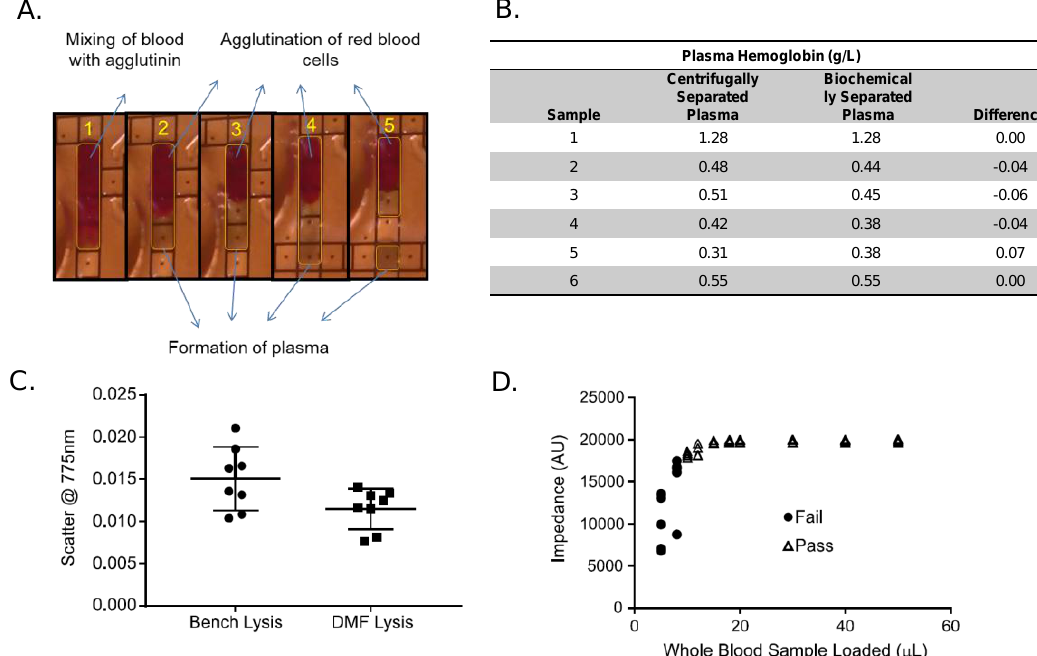
Figure 3. ( A ) Composite photograph of plasma separation on cartridge. ( B ) Hemoglobin levels in the plasma obtained from biochemical or centrifugation separation methods are not statistically di ff erent as measured by paired t-test. This study demonstrates that biochemical plasma separation does not induce excessive stress on the red blood cells (RBCs). ( C ) Whole blood from a single donor was lysed using either standard osmotic methods on the bench (left) or via osmotic lysis on the digital microfluidic (DMF) cartridge (right). The scatter at 775 nm is comparable in both samples, indicating that the DMF lysis method is as e ff ective as the standard bench osmotic shock technique. ( D ) Sample input volume (x-axis) versus impedance (y-axis); circle: fail, triangle: pass. AU: arbitrary units.